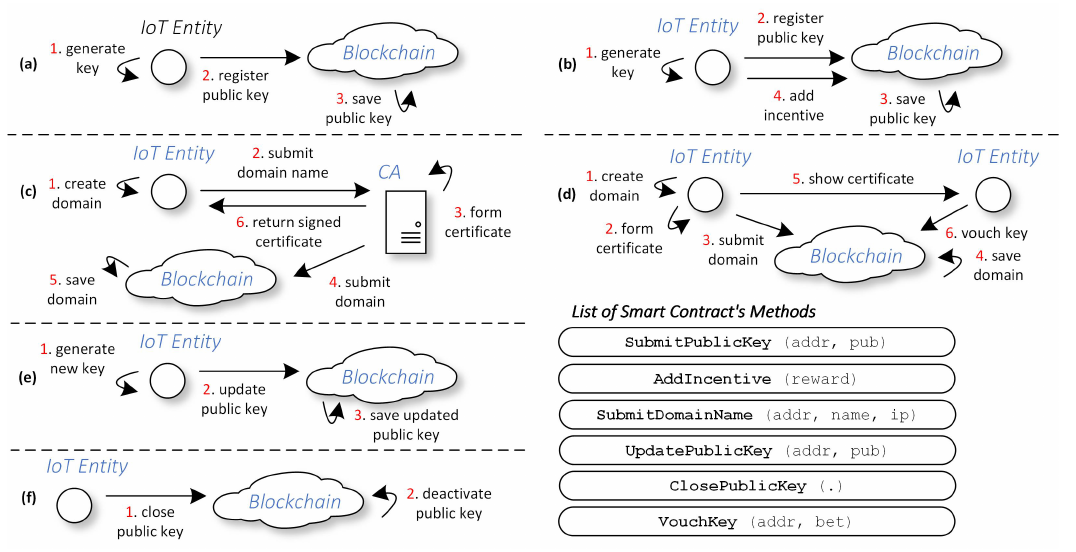
Figure 2. The overview of our decentralized identity management design: It comprises of public key registration for ( a ) the quasi-centralized and ( b ) fully decentralized approaches, namespace registration for ( c ) the quasi-centralized and ( d ) fully decentralized methods, ( e ) online key revocation, and ( f ) offline key revocation. We also show the list of required smart contract methods for